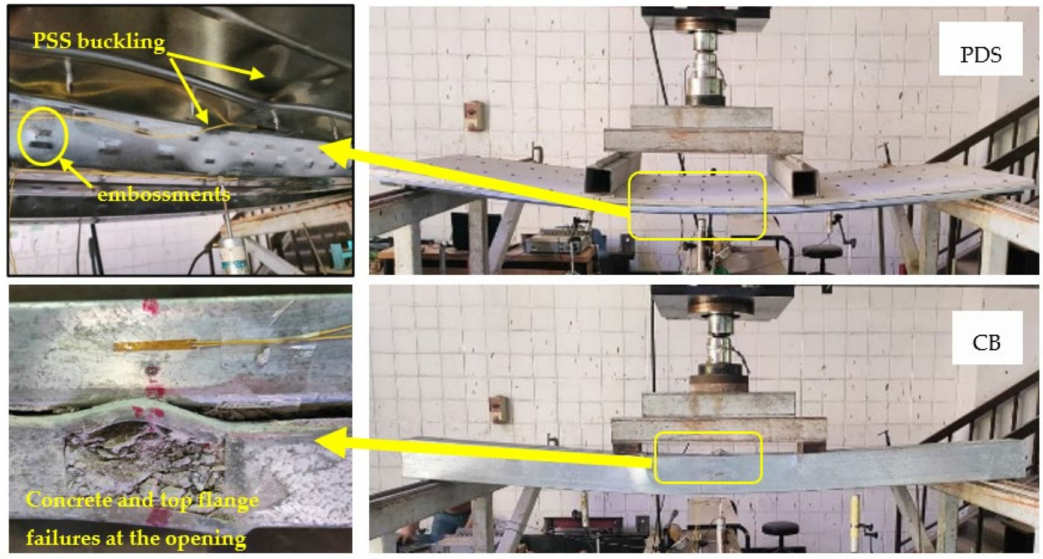
Figure 9. Typical bending behavior of control specimens PDS and